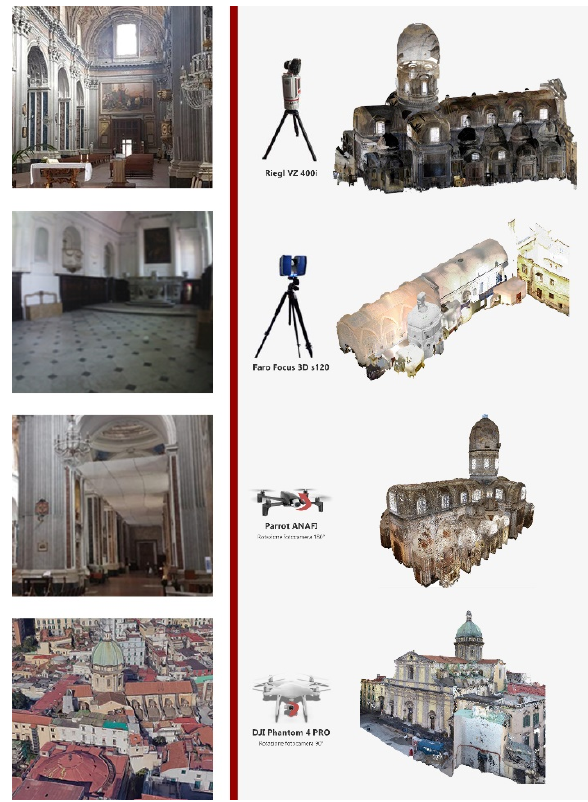
Figure 2. Overview of the morphological characteristics of the site, of the reality-based technologies used and of the 3D models obtained